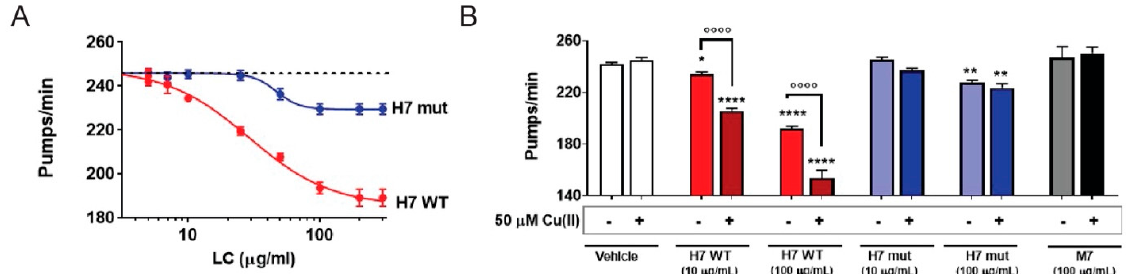
Figure 3. H7 mutant with destabilized C L domain is less toxic to C. elegans . ( A ) Dose–response curves reveal the diminished toxicity of H7-H188A/H197A (H7 mut) compared to H7 (WT), as higher concentrations are required to inhibit the pumping rate of worms. Worms were fed for 2 h with different concentrations of WT or mutated H7 suspended in 10 mM PBS, pH 7.4, and the pharyngeal pumping was scored 24 h after the administration. Control worms received vehicle alone (dotted line). Each value is the mean ± SE, n = 30. IC 50 was 28.9 and 46.8 µ g/mL for WT and mutated H7, respectively, p < 0.01, Student’s t -test. ( B ) Worms were fed for 2 h with 10 or 100 µ g/mL H7 or H7-H188A/H197A, or 100 µ g/mL M7 dissolved in 10 mM PBS, pH 7.4, with or without 50 µ M Cu (II). Control worms received 10 mM PBS, pH 7.4 with or without 50 µ M Cu (II) (vehicle). Pharyngeal pumping was determined 24 h after the administration. Each value is the mean ± SE, n = 20. * p < 0.05, ** p < 0.01 and **** p < 0.001 vs. the corresponding vehicle, ◦◦◦◦ p < 0.001, one-way ANOVA and Bonferroni’s post hoc